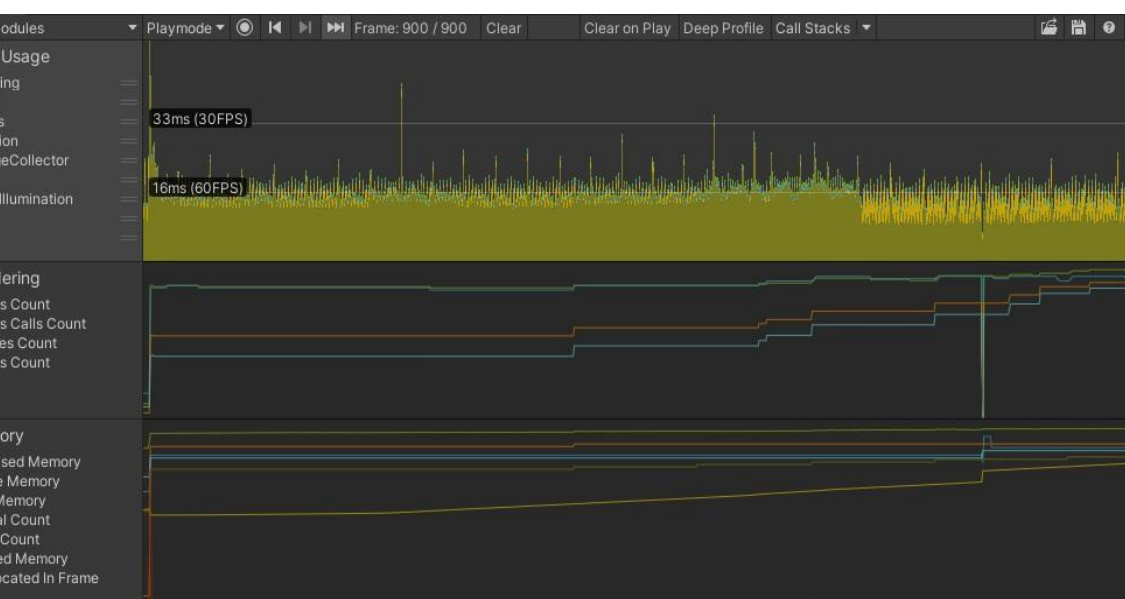
Table 2. Rendering data for both versions from the beginning frame in CPU usage